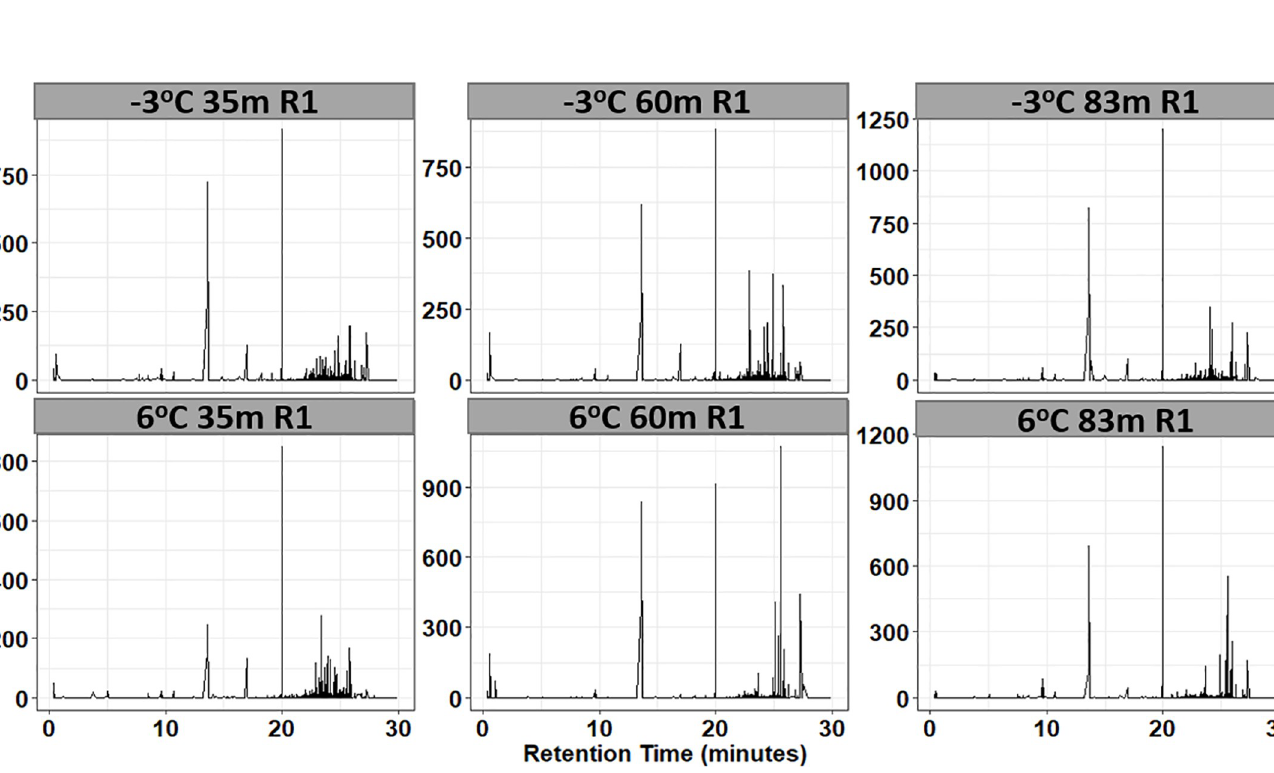
PLOS ONE | https://doi.org/10.1371/journal.pone.0232169 April 30, 2020 6 /